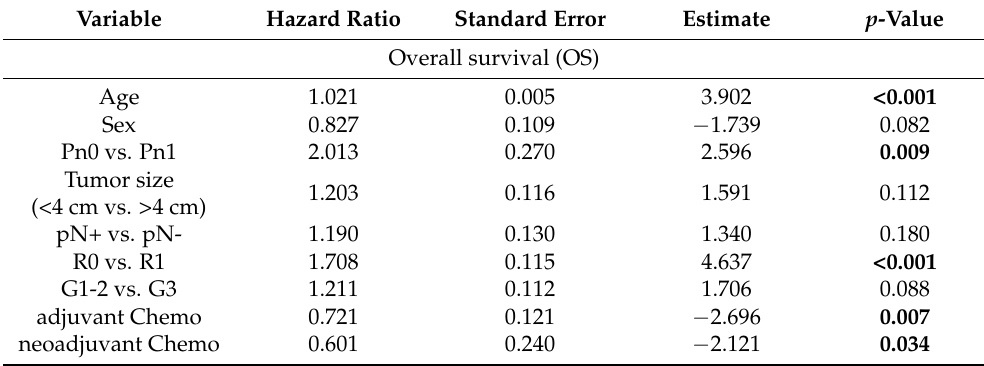
Figure 1. Overall survival and disease-free survival of patients in the Pn0 and Pn1 group. ( A ) Overall survival of Pn0 and Pn1 group. ( B ) Disease-free survival of Pn0 and Pn1 group. Table 4. Multivariate cox regression analysis of variables and their impact on OS and DFS.